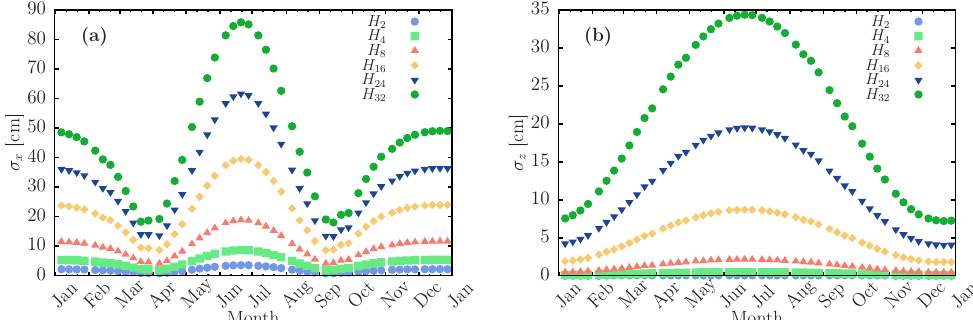
Figure 7. Daily standard deviations of facet impact points for the heliostat arrays H2, H4, H8, H16, H24, and H32 throughout the year, along the x ( a ) and z ( b ) axes. The arrays are located at 2 h (70 m).